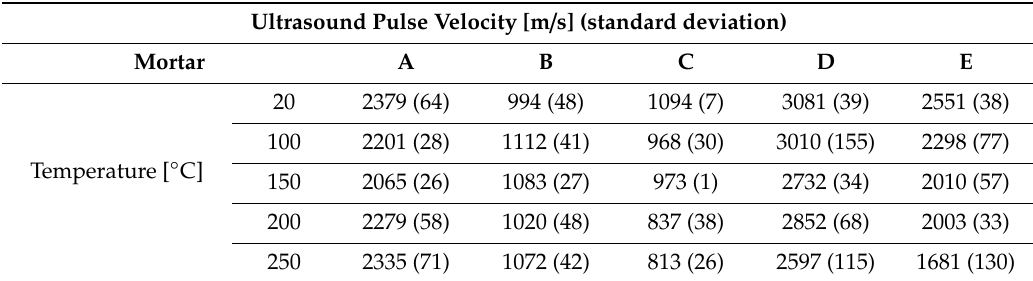
Table 3. Ultrasound pulse velocity average vs. exposure temperature.